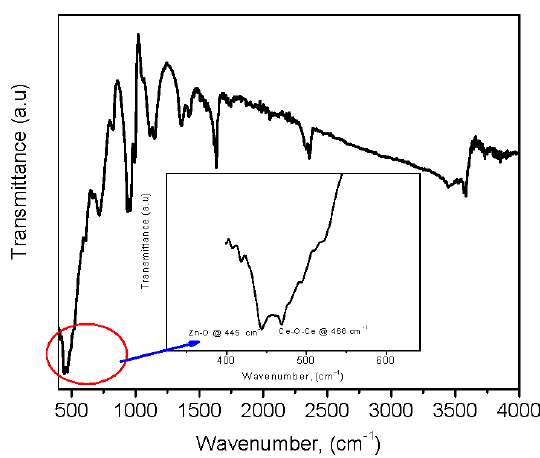
Figure 4. FTIR spectrum of CeO 2 -ZnO NPs.